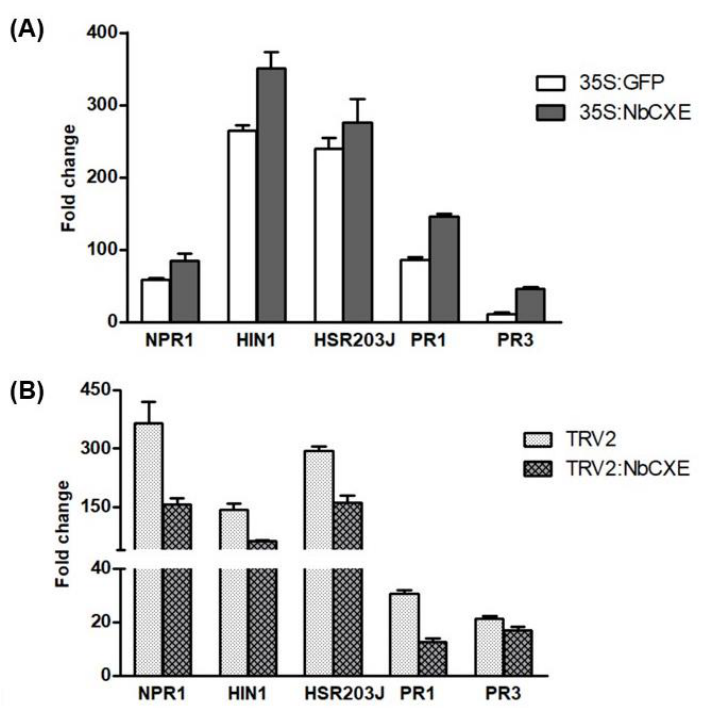
Figure 5. After TMV infection, the fold changes of selected host response genes ( NPR1 , HIN1 , HSP203J , PR1 and PR3 ) in ( A ) transient NbCXE-overexpressed and ( B ) NbCXE-silenced N. benthamiana , respectively.